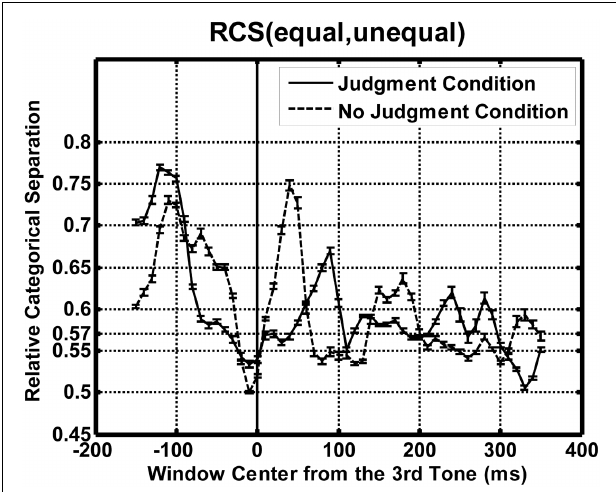
FIGURE 3 |The results of the time course analyses. Relative categorical separations are plotted as a function of the temporal position of the time-window center for each condition. Solid and dashed lines show the results for the judgment and the no-judgment condition, respectively.The “chance level” of the relative category separation is 0.57 assuming a homogeneous variance across the temporal patterns. Error bars represent SE estimated by the bootstrapping ( N =